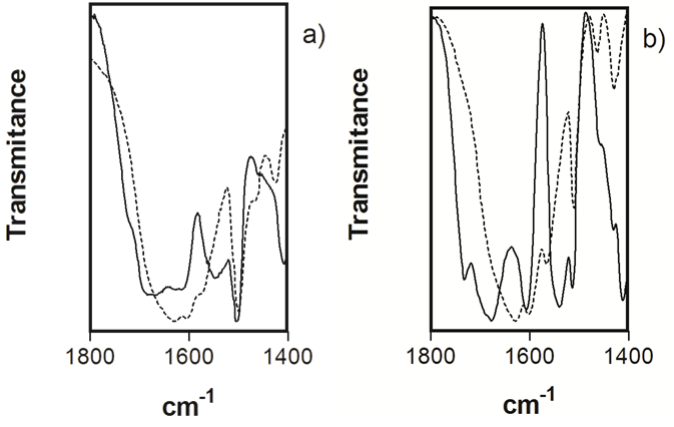
Figure 3. IR spectra for KBr pellets of ( a ) PO and Fe and ( b ) PC and Fe PC (solid and dotted line 2